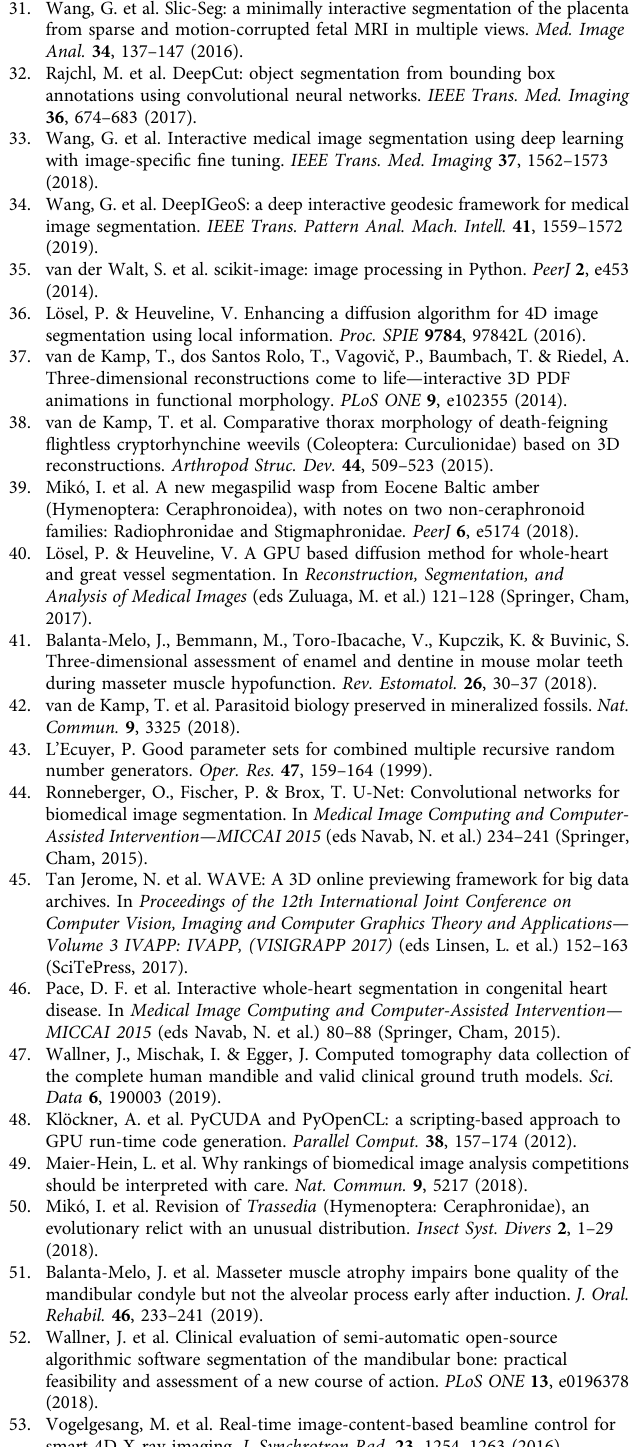
algorithmic software segmentation of the mandibular bone: practical feasibility and assessment of a new course of action. PLoS ONE 13 , e0196378 (2018). 53. Vogelgesang, M. et al. Real-time image-content-based beamline control for smart 4D X-ray imaging. J. Synchrotron Rad. 23 , 1254 – 1263